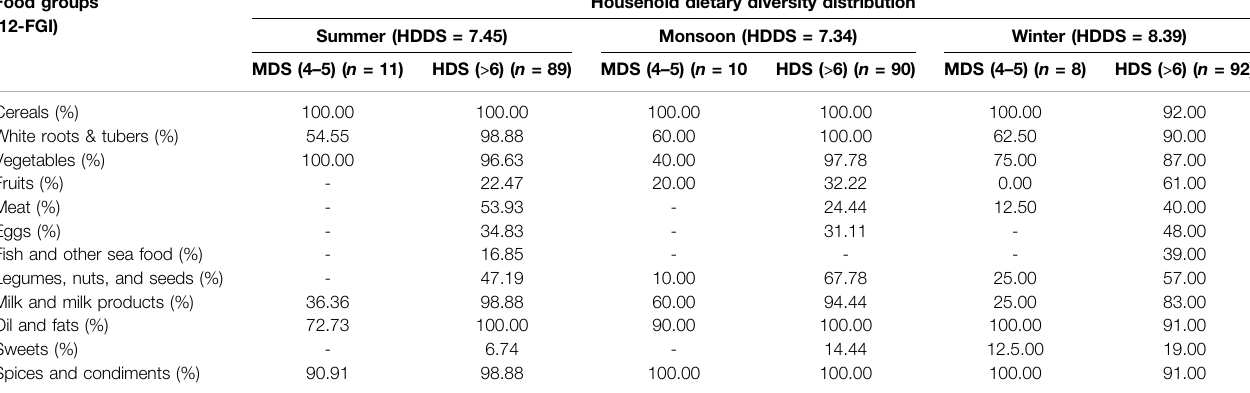
Household dietary diversity